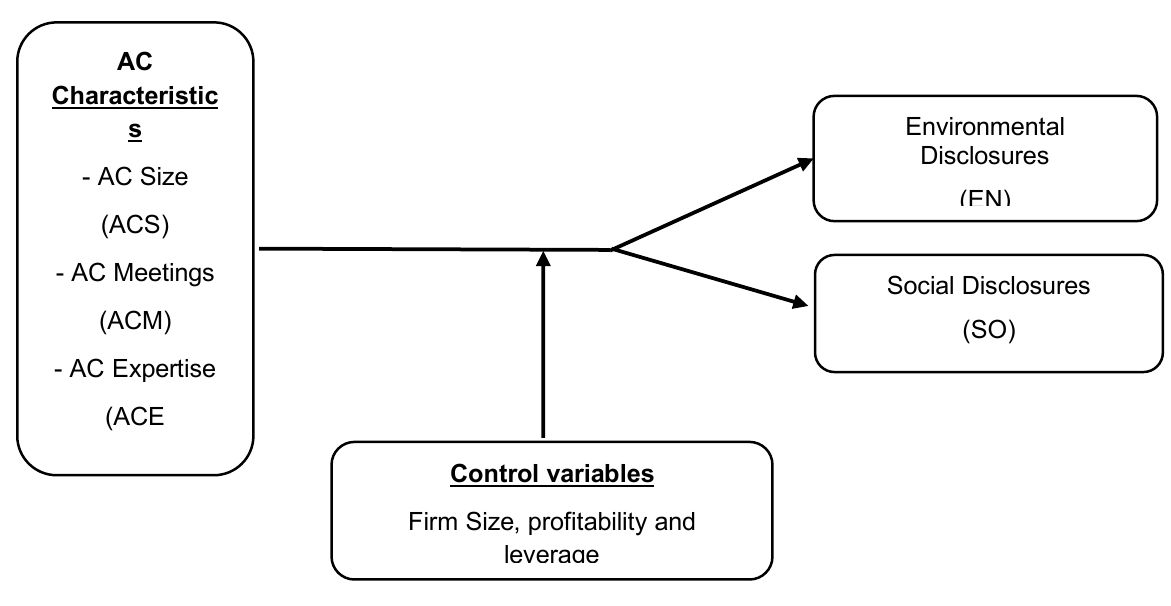
Figure 1: The theoretical